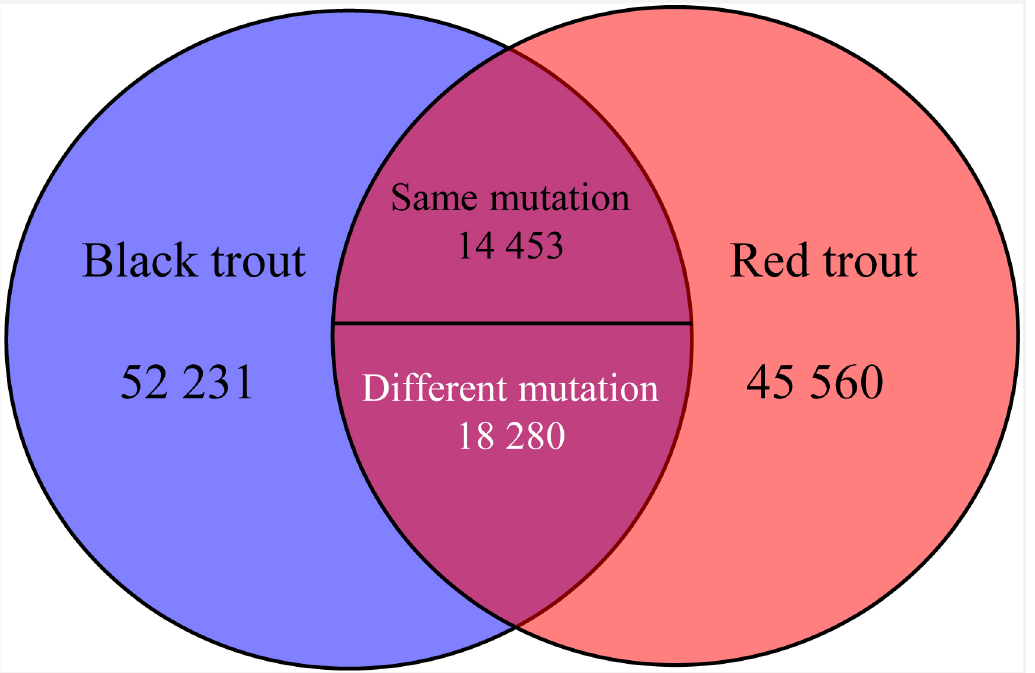
Fig 3. Venn diagram showing the difference and overlap in terms of the number of putative SNPs for the transcriptome of black and red common coral trout.